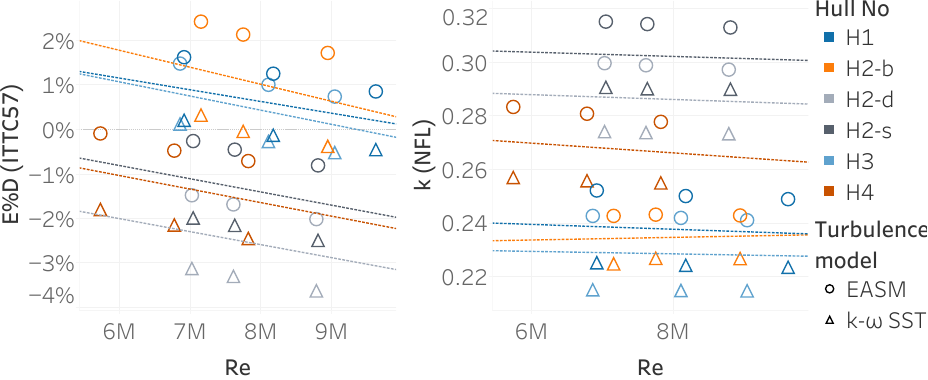
Figure 10. Comparison error of all test cases for the speed variations, ( a ) using the ITTC-57 line and ( b ) using the